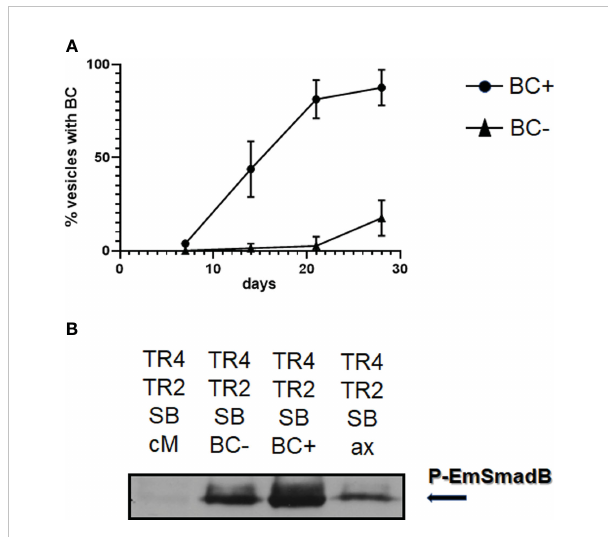
FIGURE 10 Induction of BC formation by culture supernatant. (A) In fl uence of supernatant from BC containing and BC free vesicles on BC formation. Metacestode vesicles of isolate MP17 were grown for 28 days in co-culture in the presence of conditioned medium obtained from cultures with BC containing vesicles (BC+) or BC free vesicles (BC-). BC formation was assessed light microscopically. Shown are median with standard deviation. Unpaired t-test as assessed by GraphPad prism revealed (p < 0.0001) at day 14 between BC+ and BC-. (B) In fl uence of culture supernatant on the activity of Echinococcus TGF b /BMP receptors. The E . multilocularis receptors EmTR4 and EmTR2 were co-expressed with EmSmadB in HEK 293 T cells and exposed to supernantant from cultures with BC containing vesicles (BC+), BC free vesicles (BC-), or from axenically cultured vesicles (ax). Conditioned medium (cM) was used as a control. Cell lysates were subjected to PAGE and Western blot analysis using an antibody against phosphorylated EmSmadB. Arrow to the right indicates the phosphorylated R-Smad forms. Comparative amounts of total R-Smad, as measured using an anti-Myc-tag antibody, were applied to the gel. Result shows representative example of experiment performed in